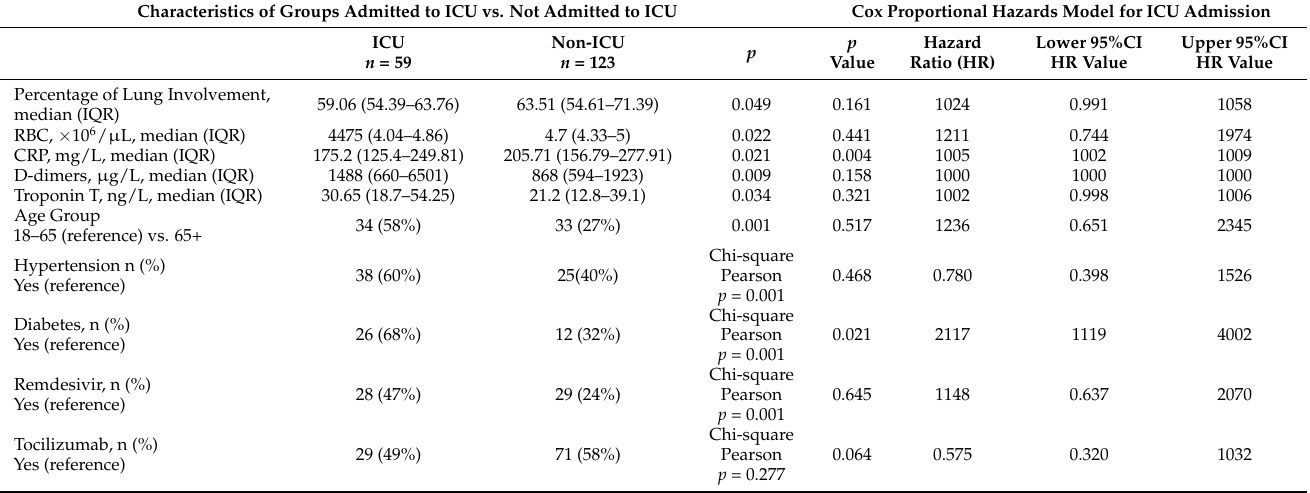
Table 2. Characteristics of groups admitted to ICU vs. not admitted to ICU.